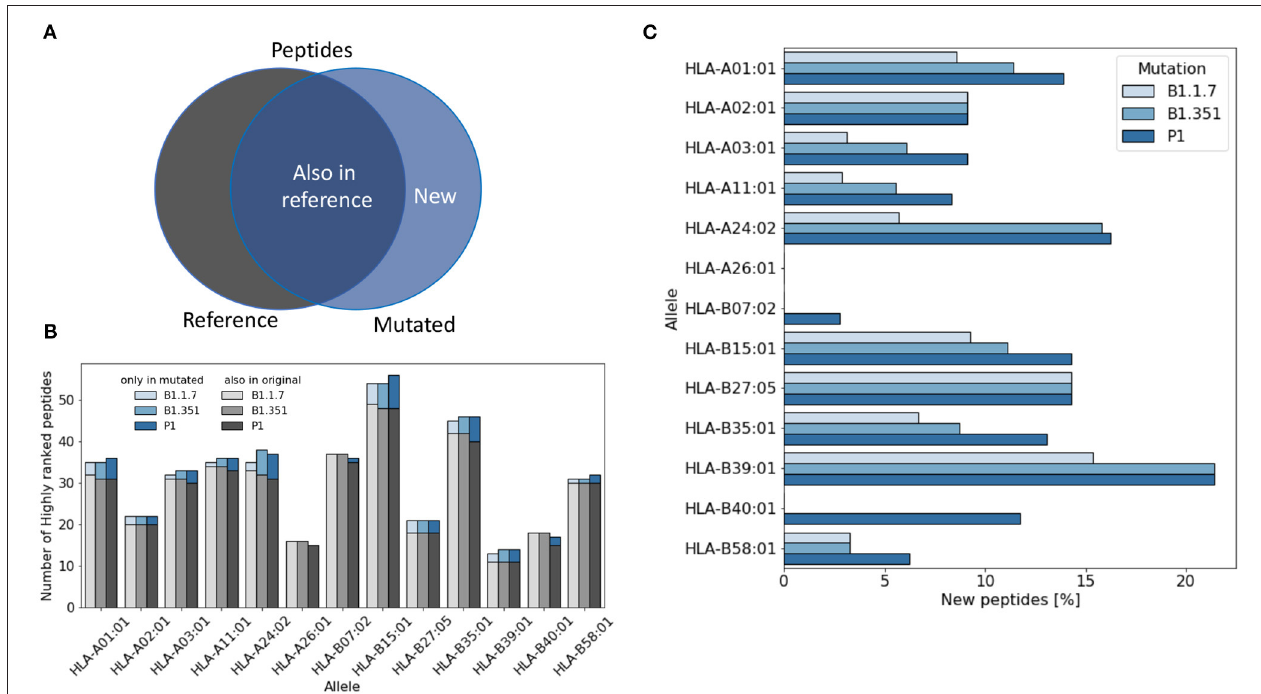
FIGURE 1 | Variation of the number of T cell epitopes in virus variants. (A) We distinguish potential epitopes in virus variants according to their presence in the reference Sars-Cov-2 virus genome. (B) The total number of highly ranked peptides for each allele is reported for each virus variant and each allele. (C) The fraction of highly ranked peptides that were not present in the reference genome is reported for each variant and each